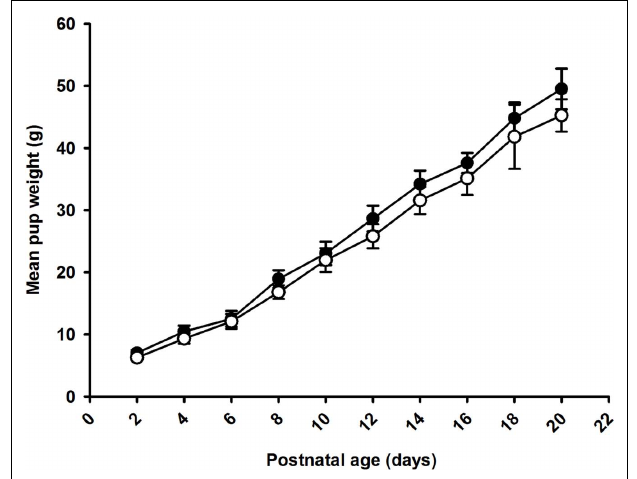
FIGURE 1 |Weight gain from birth to weaning in Control (open circles) and Omega-3 (closed circles) offspring. The effect of Omega-3 treatment on weight gain from birth to weaning was assessed by a one-way ANOVA with repeated measures. Data from male and female offspring combined. There was no effect of maternal omega-3 supplementation on weight gain of the offspring from birth until weaning. BODY COMPOSITION There was no effect of maternal omega-3 supplementation on the total or relative weight of any of the major visceral or sub- offspring ( Table 5